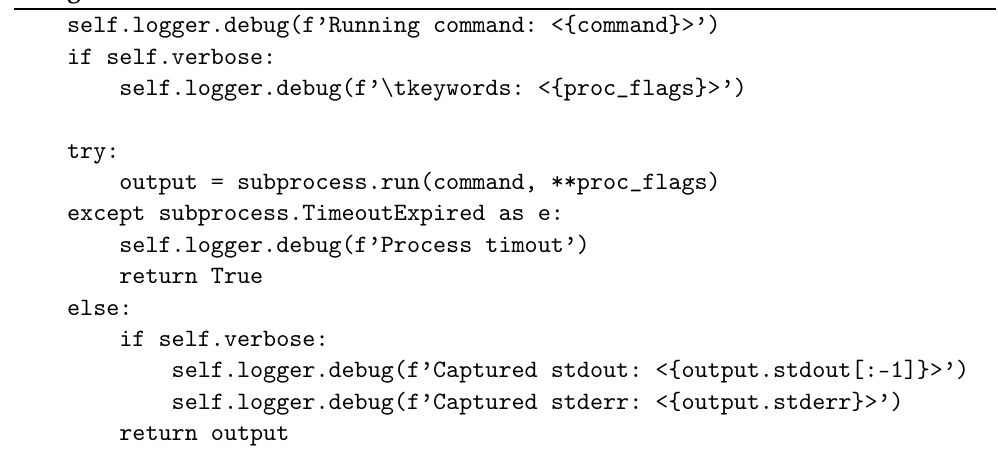
Algorithm 2: Part of the "run" function within the abstract ToolExecutor